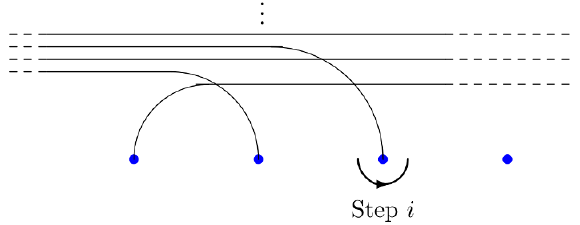
Figure 3 . Chord Diagram Recursions: A previous line closes.